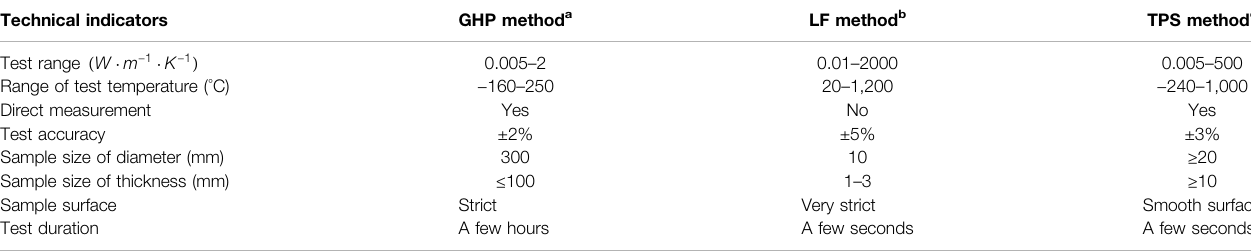
TABLE 1 | Thermal conductivity test method comparison. Technical